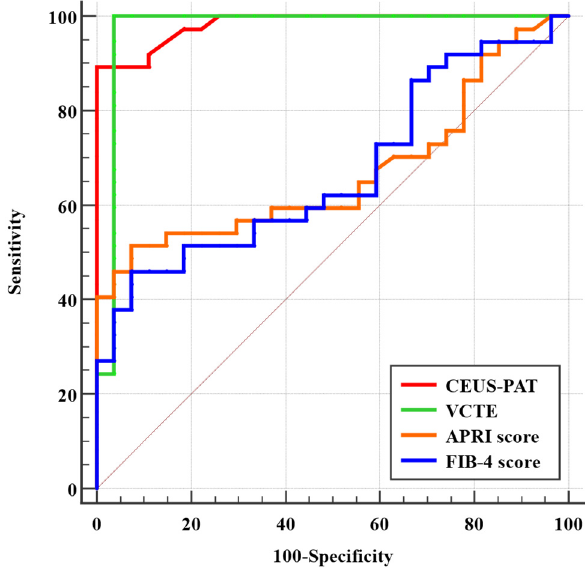
Figure 7. ROC curve analysis comparing the four methods.